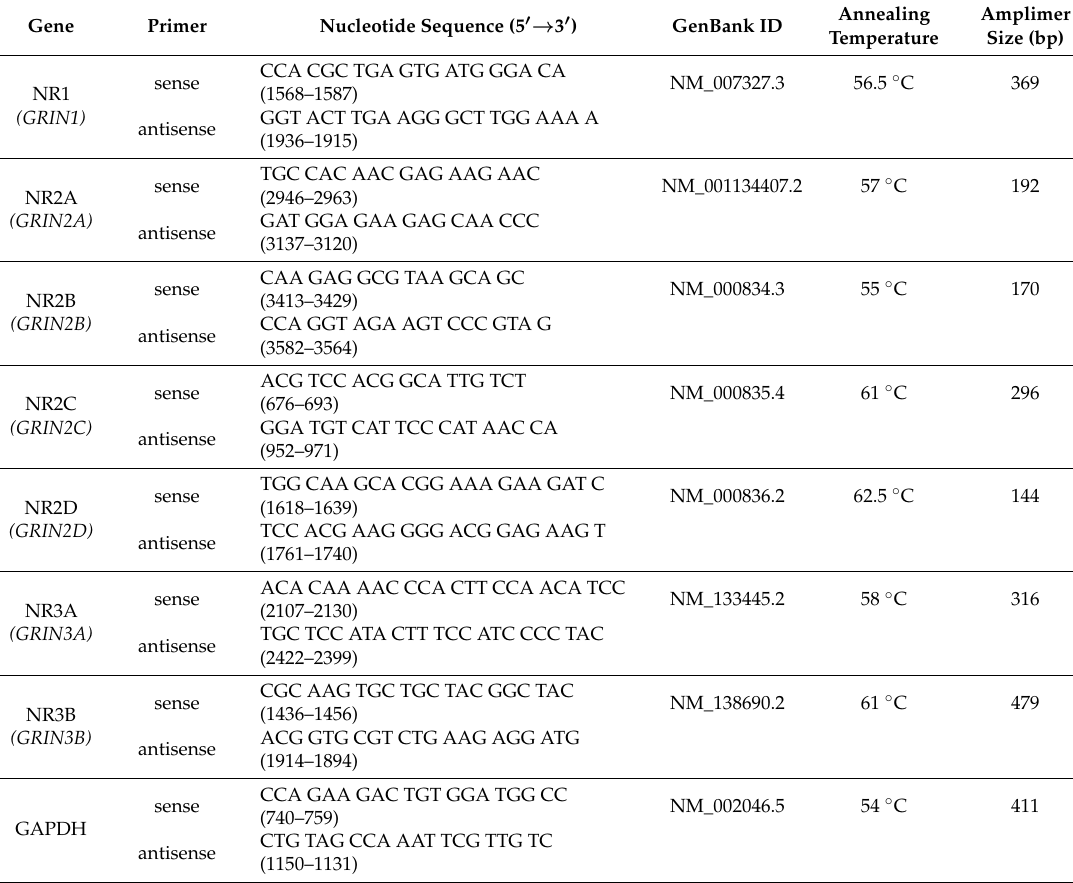
Table 1. Nucleotide sequences, amplification sites, GenBank accession numbers, amplimer sizes and PCR reaction conditions for each primer pair are